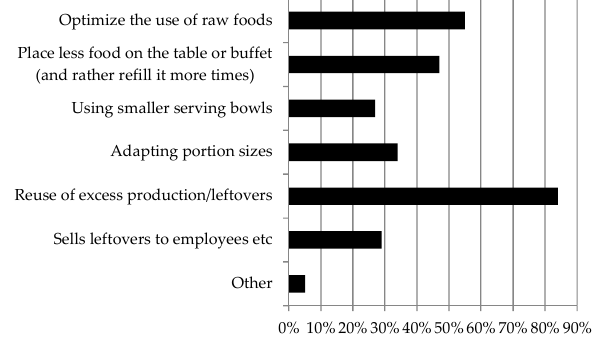
Figure 2. Food waste reduction priorities among canteens in elementary schools, upper secondary schools and workplaces that focus on food waste reduction “somewhat”, to “a high degree” or “a very high degree” (%) ( n = 638).